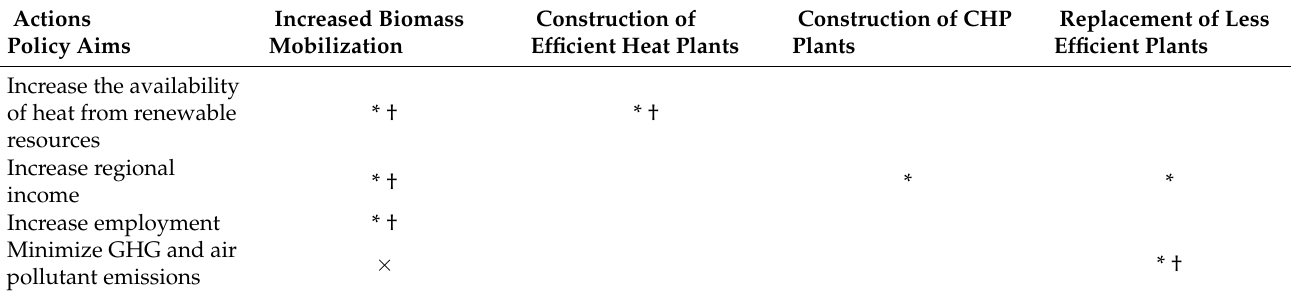
Table 6. Summary of policy aims and actions the scenarios considered were based on. * and † indicate that the action positively addresses the policy aim in question (* for wood chips value chain and † for wood pellets value chain), and × indicates that the action negatively addresses